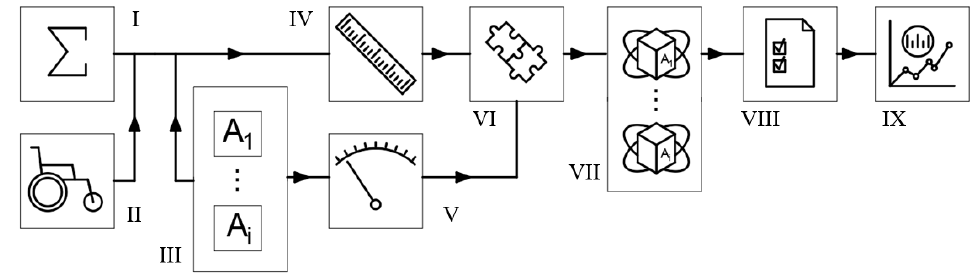
Figure 1. Diagram illustrating the course of research works; I—analytical development of the force system acting on the wheelchair, II—development of a wheelchair with a hybrid drive, III—adaptation of simulation variants for the purpose of measuring variable parameters at the test stand, IV—measurements of constant parameters on the test stand, V—measurements of variable parameters on the test stand, VI—introducing the input parameters to the simulation, VII—performing the simulation in the environment for numerical calculations for all the adopted variants, VIII—calculation of the work time coverage based on the simulation results and the characteristics of the engine and the supply system, IX—summary of the results for all variants.